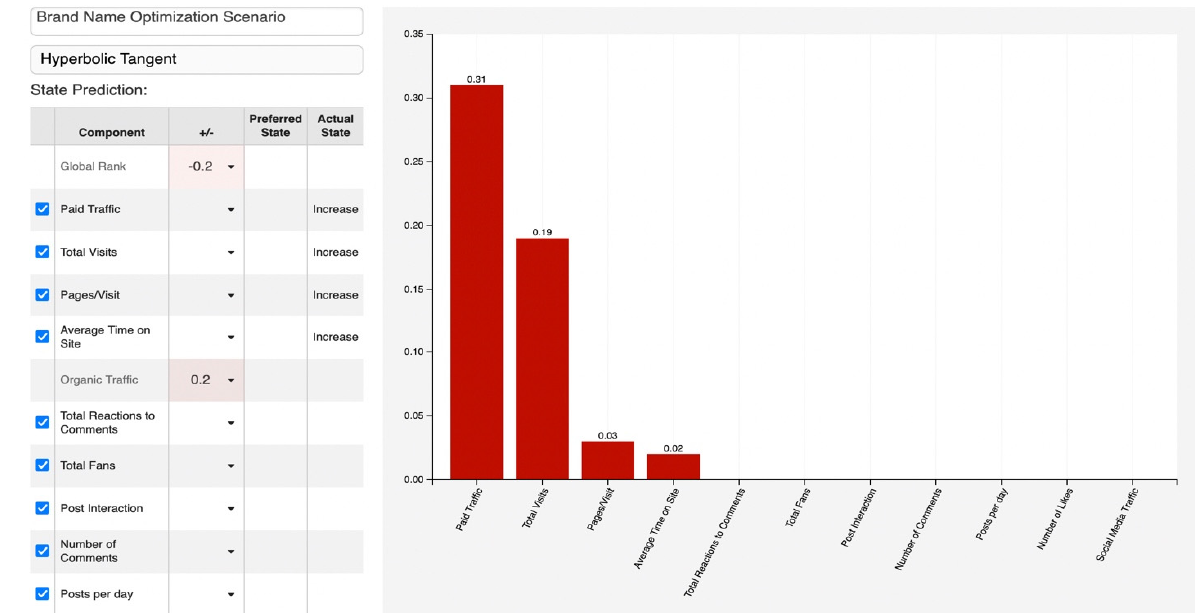
Figure 4. Digital brand name optimization scenario.